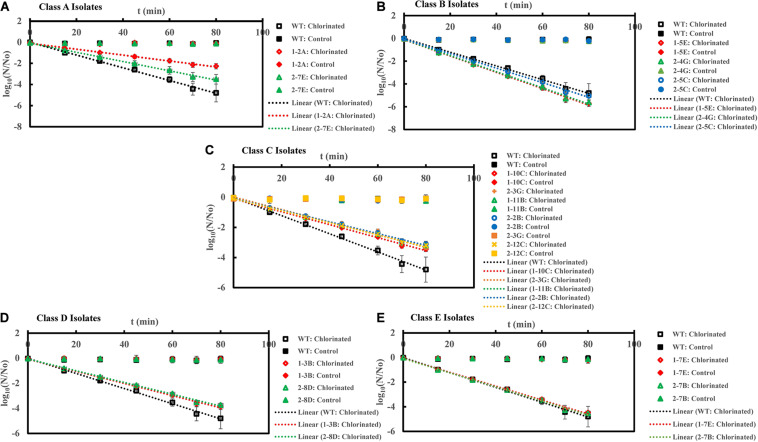
Inactivation curves of E. coli PI-7 WT and 5 categories of PI-7 transposon mutants exposed to chlorination in buffer. Best-fit curves for chlorination are reconstructed from the decay phase of inactivation curves. Half-lives derived from decay constants were also calculated from the portion corresponding to decay phase of chlorination in the inactivation curves. (A) Inactivation curves of PI-7 WT and resistant isolates (Class A isolates) exposed to chlorination; (B) Inactivation curves of PI-7 WT and susceptible isolates (Class B isolates) exposed to chlorination; (C) Inactivation curves of PI-7 WT and isolates with enhanced virulence (Class C isolates) exposed to chlorination; (D) Inactivation curves of PI-7 WT and isolates with enhanced oxidative stress response (Class D isolates) exposed to chlorination; (E) Inactivation curves of PI-7 WT and isolates with enhanced motility and siderophore production (Class E) exposed to chlorination.